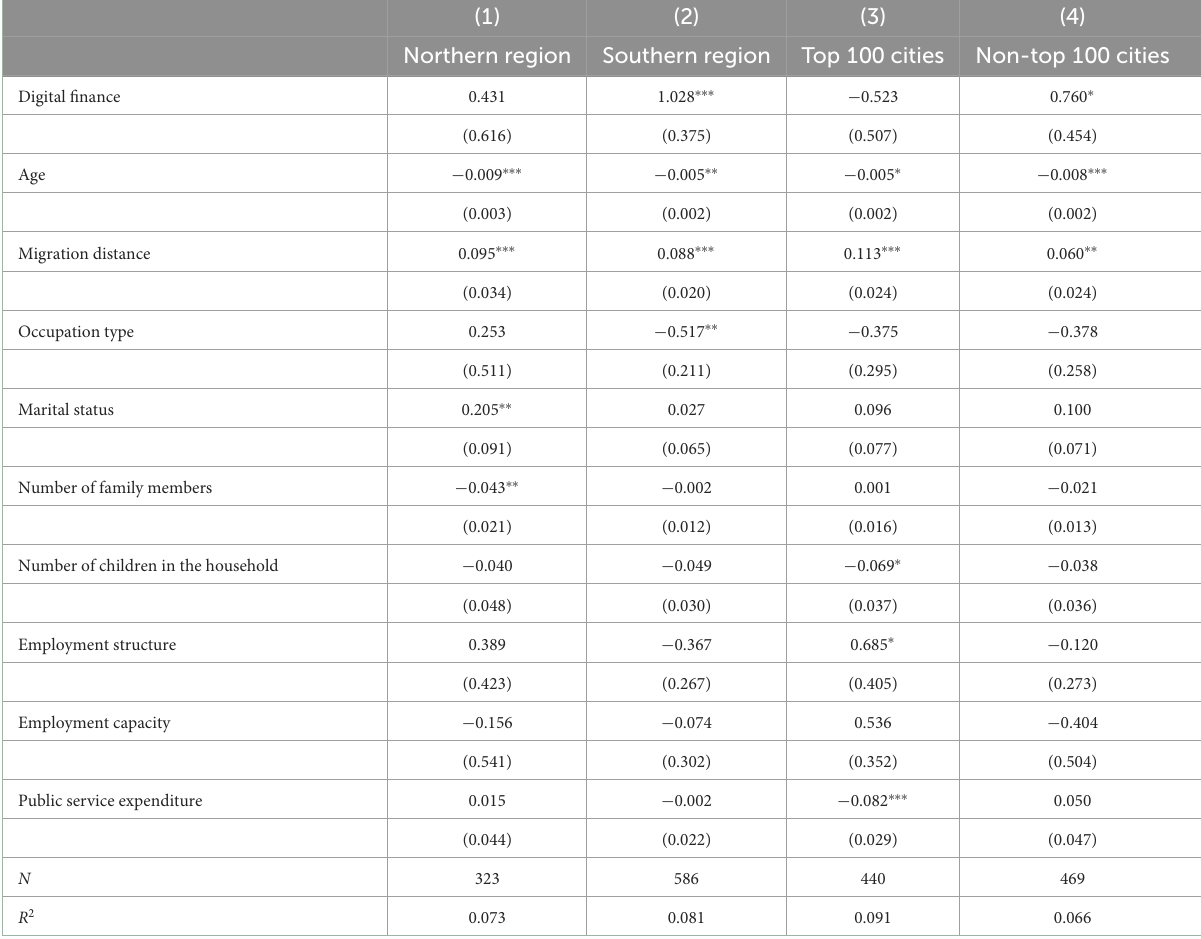
TABLE 10 Regression results of heterogeneity